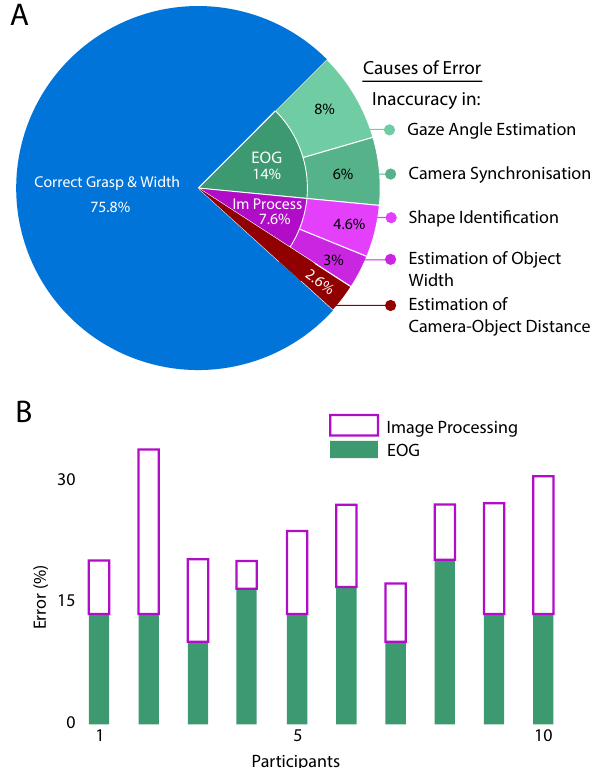
Figure 7. ( A ) Overall, the proposed system achieved an accuracy of 75.8% in selecting the object and recognizing the correct grasp orientation and size. In 14% of trials, the position of the camera caused the misinterpretation of the EOG peak. In 7.6% of trials, an error occurred in the image processing unit. In 2.6% of the trials, an error occurred due to inaccurate distance calculation; ( B ) Distribution of errors in decision making with respect to individual